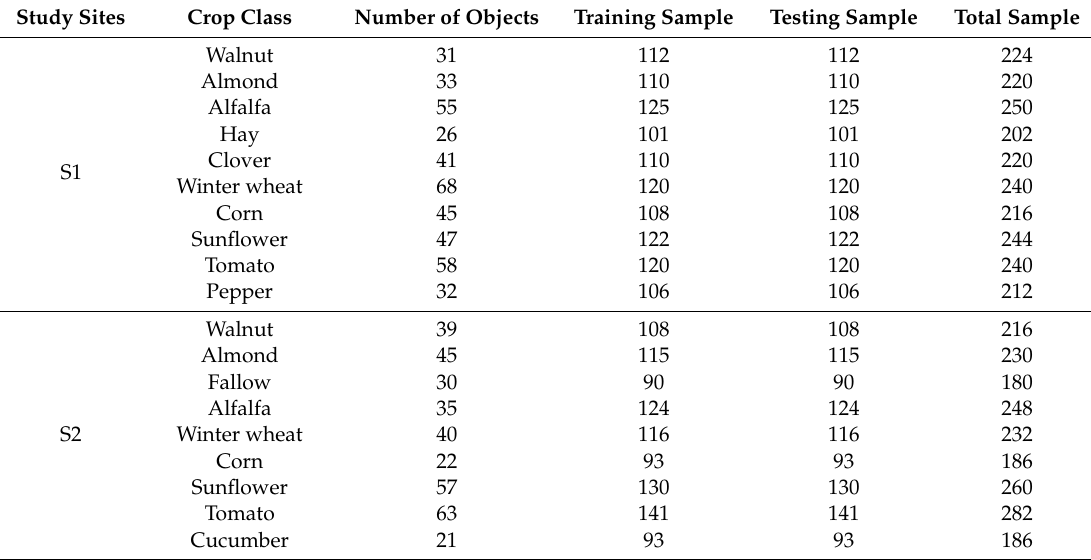
Figure 4. The two study sites S1 and S2 over the agricultural district of the Sacramento Valley, California.